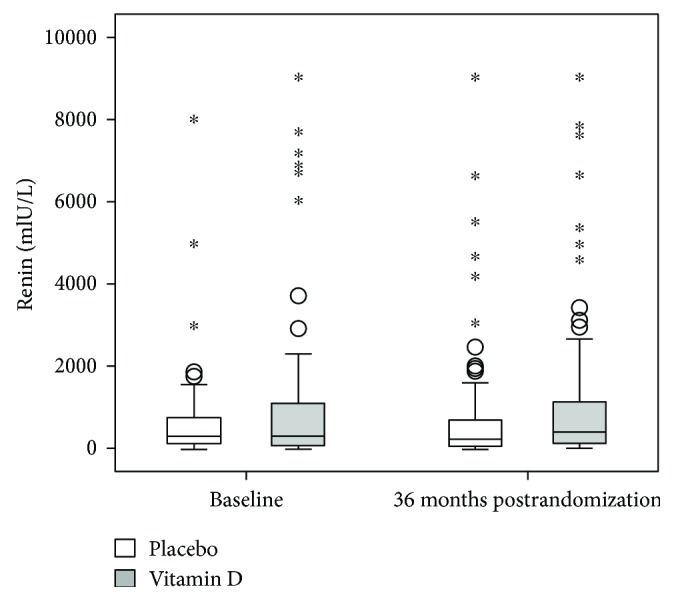
Plasma concentrations of renin are illustrated at baseline and study termination. The boxes express the upper and lower quartiles, and the central lines show the median. Whiskers indicate the 5%–95% range, circles designate outliers, and stars denote extremes. Statistical analyses are presented in the Results section.